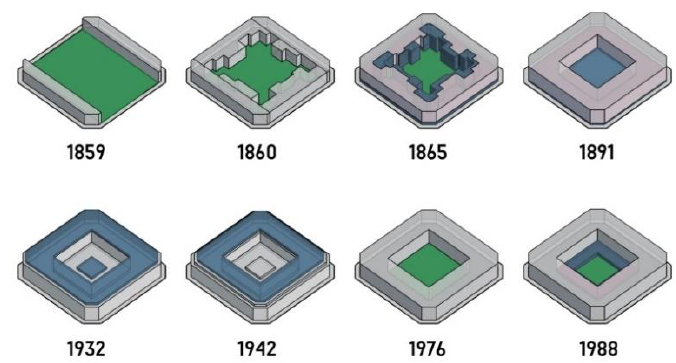
Figure 2. Development of a typical block in the Eixample throughout history.